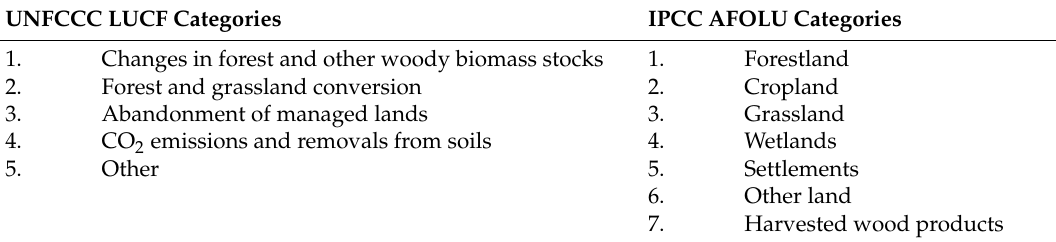
Table 3. Land Use Change and Forestry (LUCF) categories in the UN Framework Convention on Climate Change (UNFCCC) 2011 Reporting Guidelines [43] and corresponding Agriculture, Forestry and Other Land Use (AFOLU) categories in the Intergovernmental Panel on Climate Change (IPCC) 2006 Guidelines